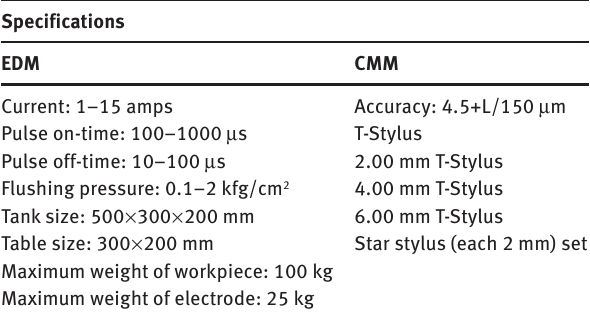
Table 2 Specifications of EDM and